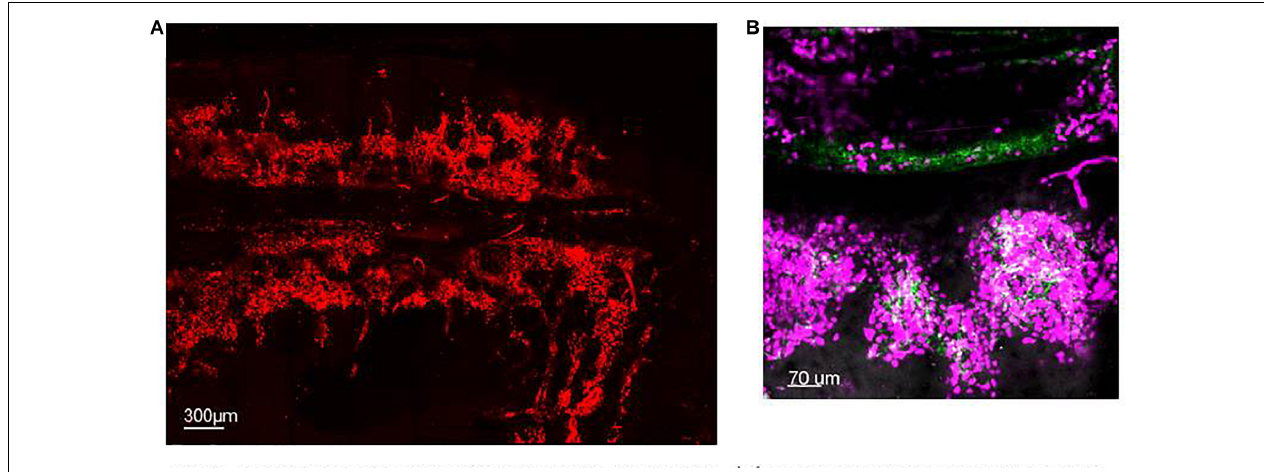
FIGURE 1 | Spatial organization of neutrophils in the BM. (A) Maximum projection of IVM tile scan image showing the spatial organization of neutrophils within the calvarium of mice (red). (B) Maximum projection of IVM tile scan image of the calvarium of mice showing clusters of neutrophils (magenta) tightly organized around BM blood vessels